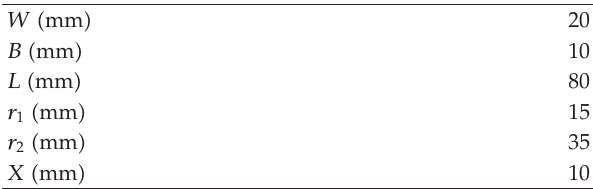
Table 1: Geometrical dimension of specimens.